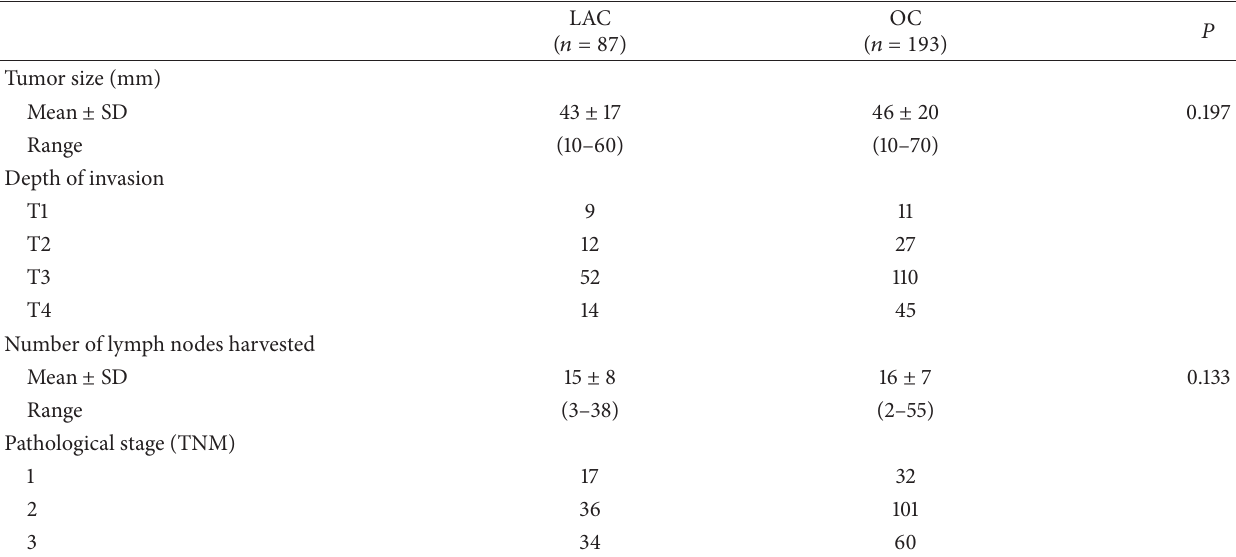
Table 3: Pathological outcomes.